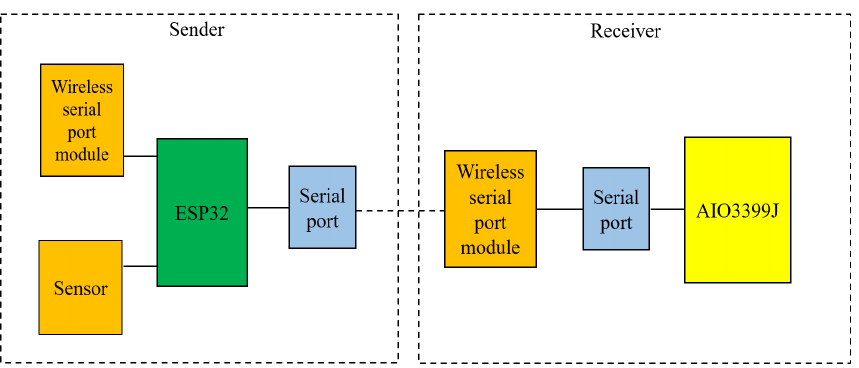
Figure 5. Schematic diagram of wireless serial